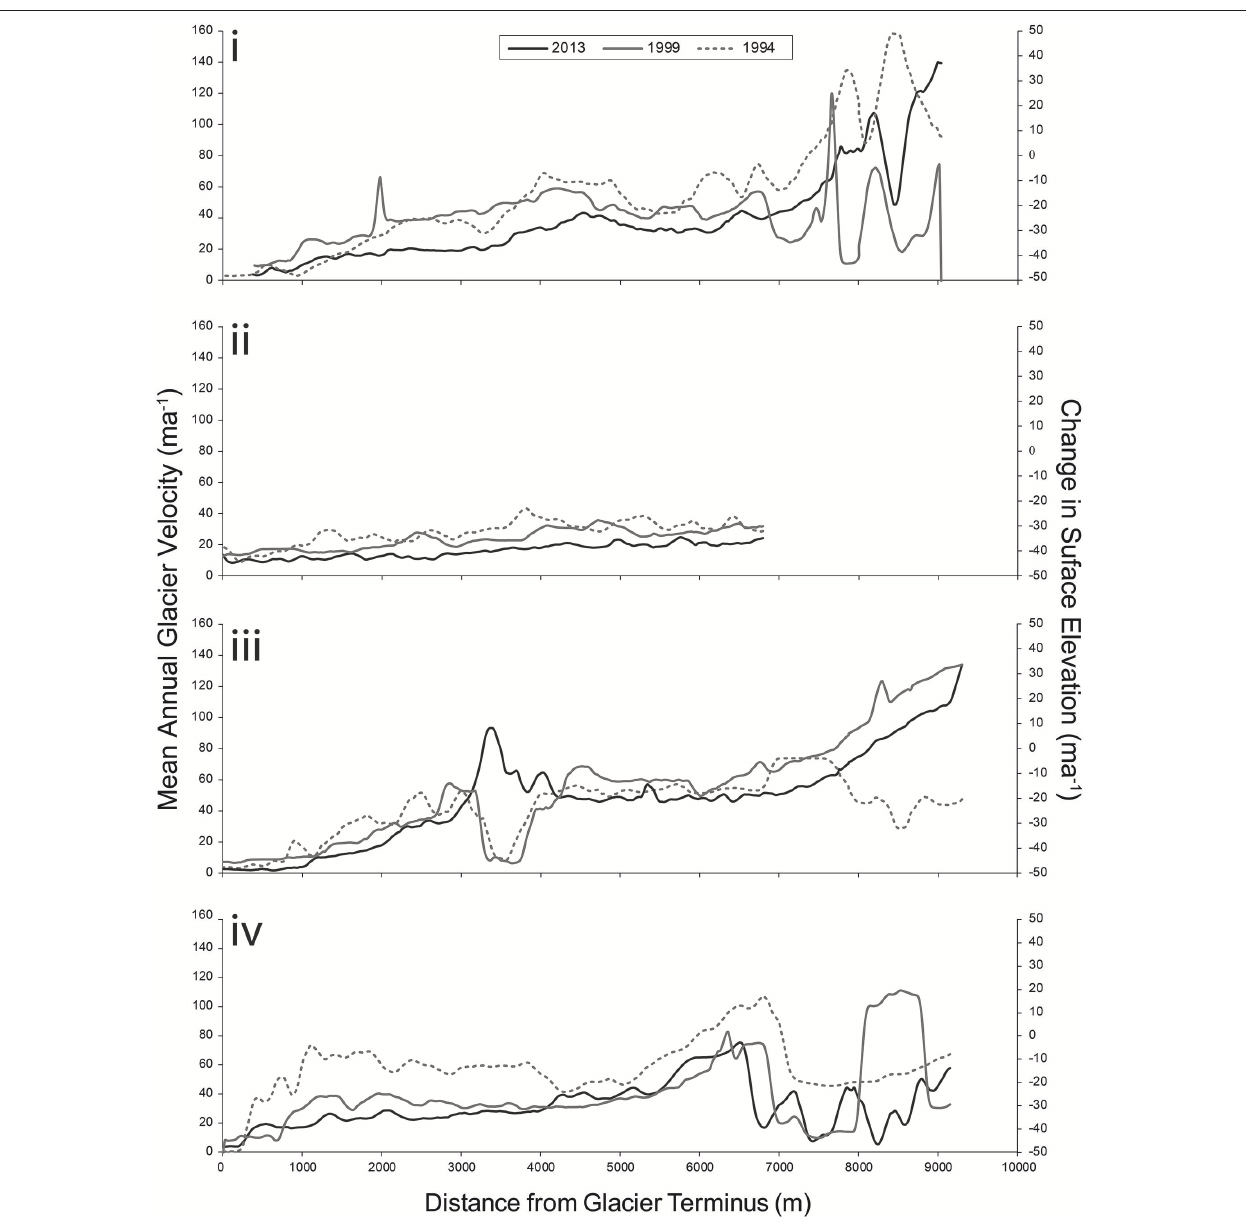
FIGURE 9 | Velocity profiles from G084350E28675N (i) , G084456E28737N W (ii) , G084456E28737NE (iii) , and G084684E28407N (iv) from 1993/1994, 1999/2000, and 2013/2013. The locations of these glaciers are shown in Figure 8